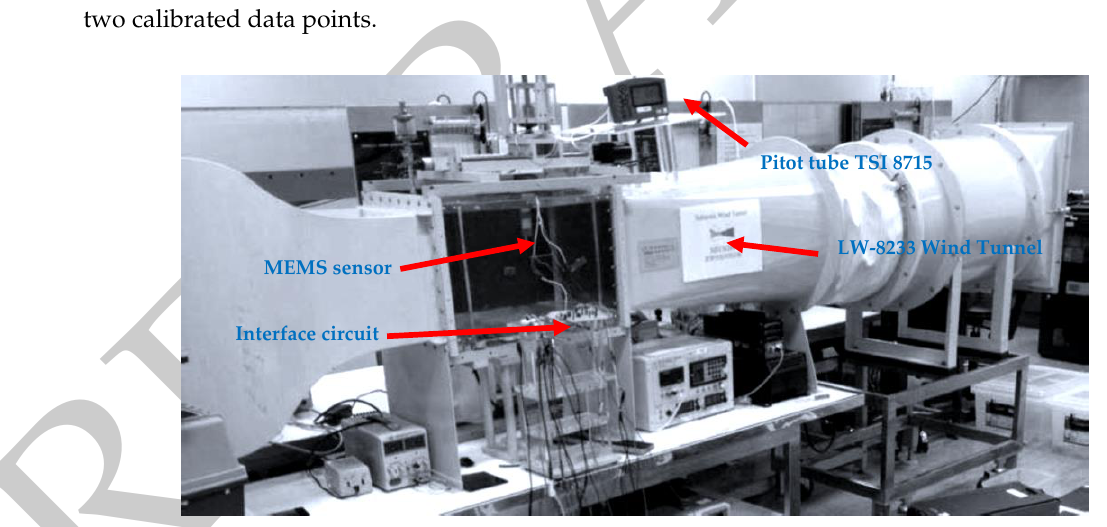
Figure 10. Experimental setup for the micro-electro-mechanical systems (MEMS) calorimetric sensor testing in the wind tunnel with the reference flow velocity read by Pitot tube. Table 2. Comparison between the reported calorimetric flow sensor and current work.